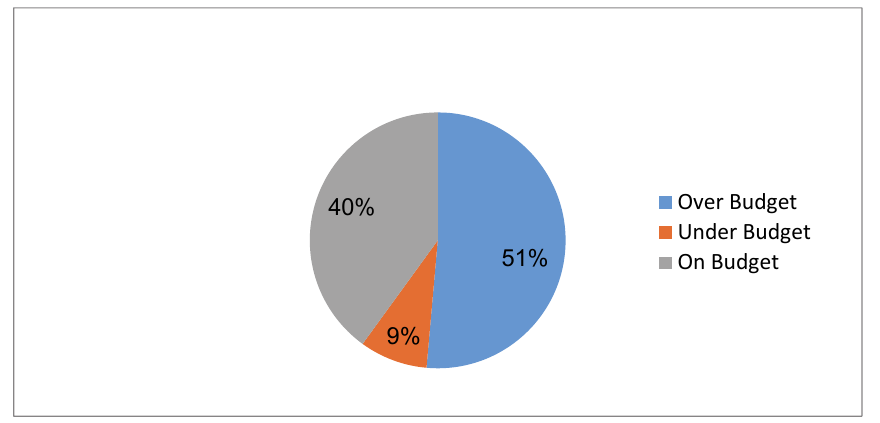
Fig. 4. Statistics on budget in ERP implementations in SMEs (source: Saini et al.,